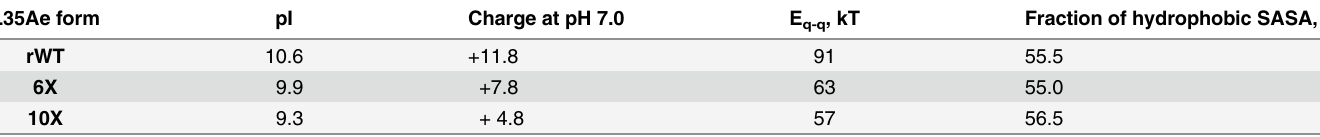
Table 4. Physico-chemical properties of the recombinant forms of L35Ae from P . horikoshii used in the present study. L35Ae